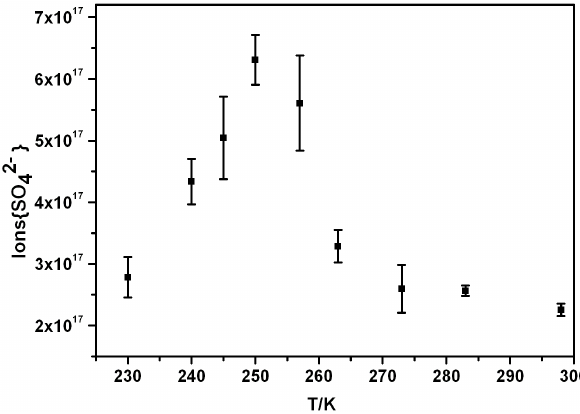
Fig. 6. The concentrations of sulfate ions at different tem- peratures after CaCO 3 particles exposed simultaneously to SO 2 (4.9 × 10 14 moleculescm − 3 ) and O 3 (4.9 × 10 14 moleculescm − 3 ) for